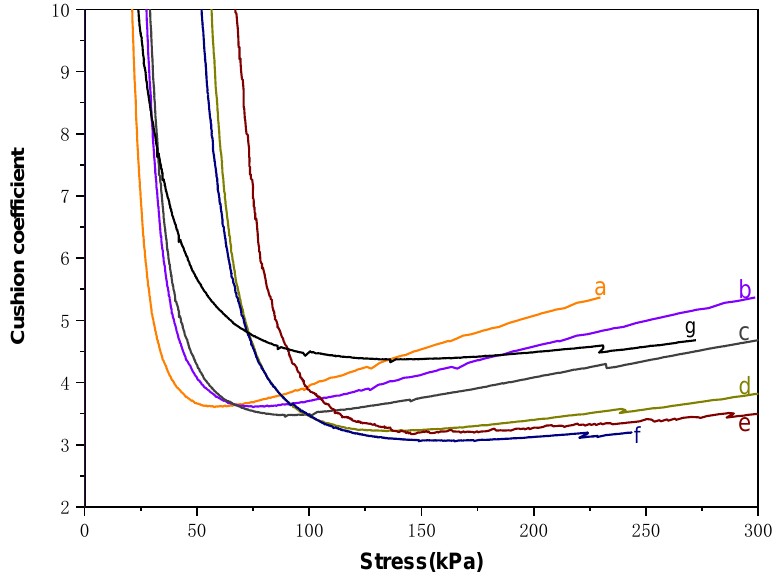
Figure 10. Cushion coefficient of materials with different sodium tetraborate contents.